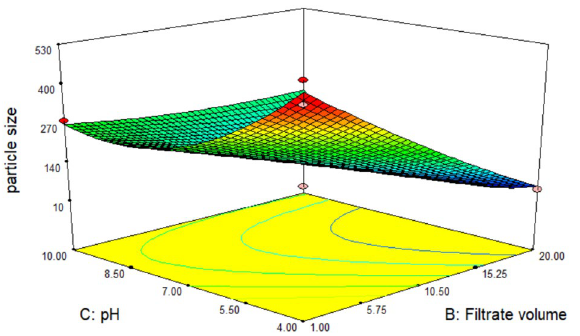
Figure 14. 3-D. Response surface plot showing the interaction between the pH and filtrate volume and its effect on the produced particle size.